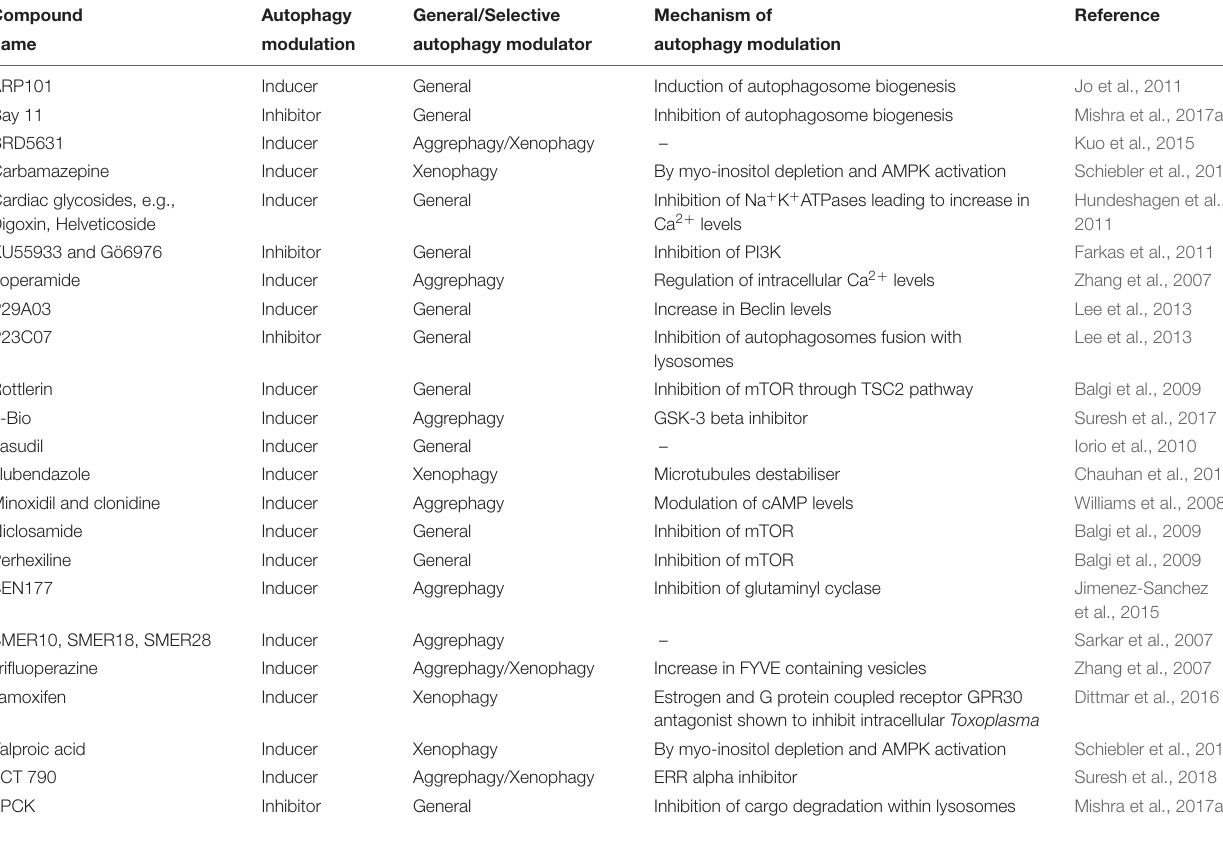
TABLE 1 | Autophagy modulators identified through High Throughput Screening of Chemical compound libraries.